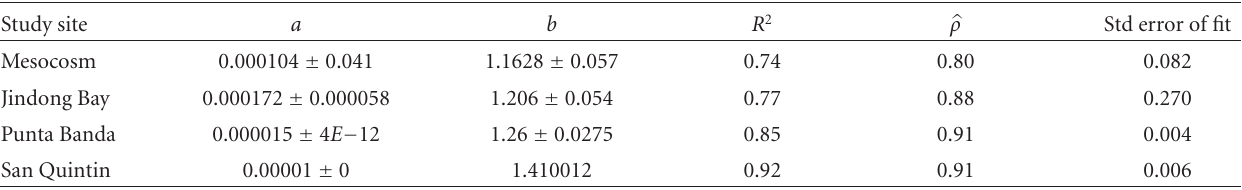
Table 1: Values of the parameters a and b , standard errors, R 2 , (cid:11) ρ and standard error of the fit resulting from the fittings of the allometric models of (1) or (8).